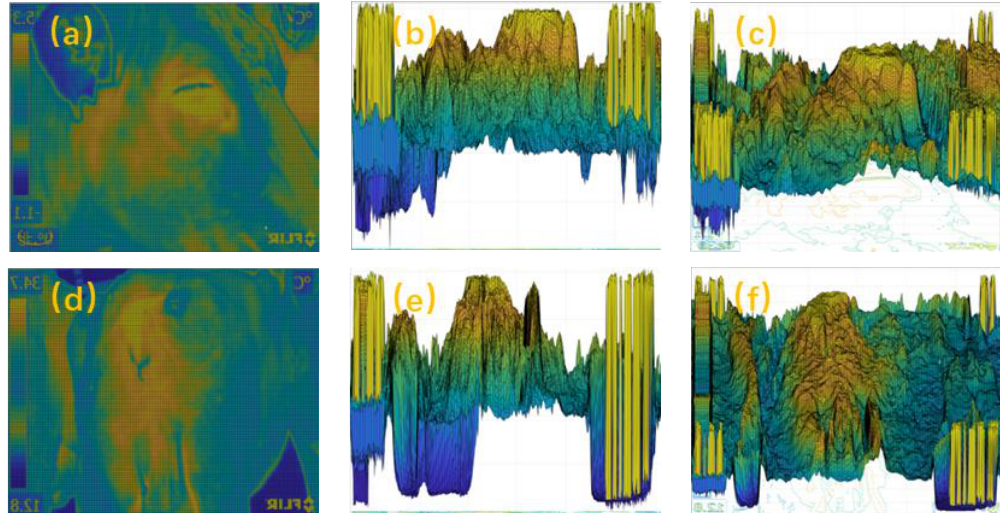
◦ stereo view, ◦ rotation of vulva,